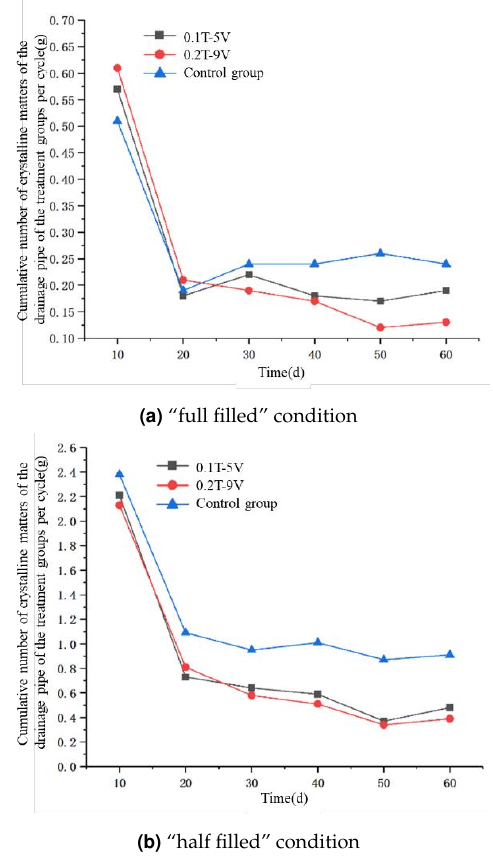
Fig. 14. Anti-crystallization efficiency of electromagnetic compound field under the water filling condition over time. combination of